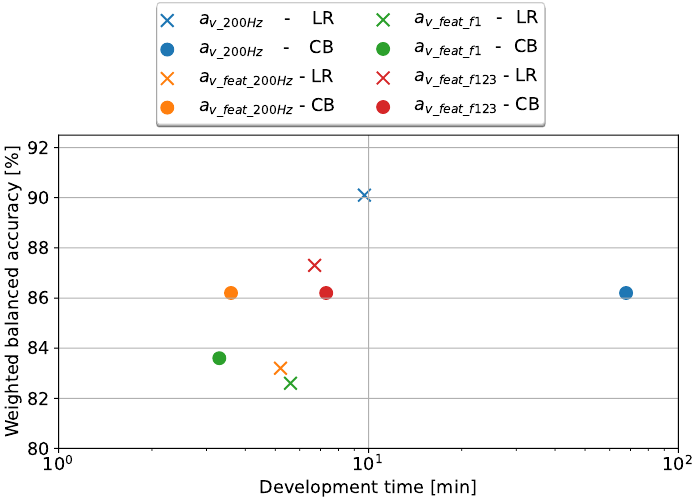
Figure 12. The computation time required to develop a classifier vs. the weighted BAC of classifiers trained with different input